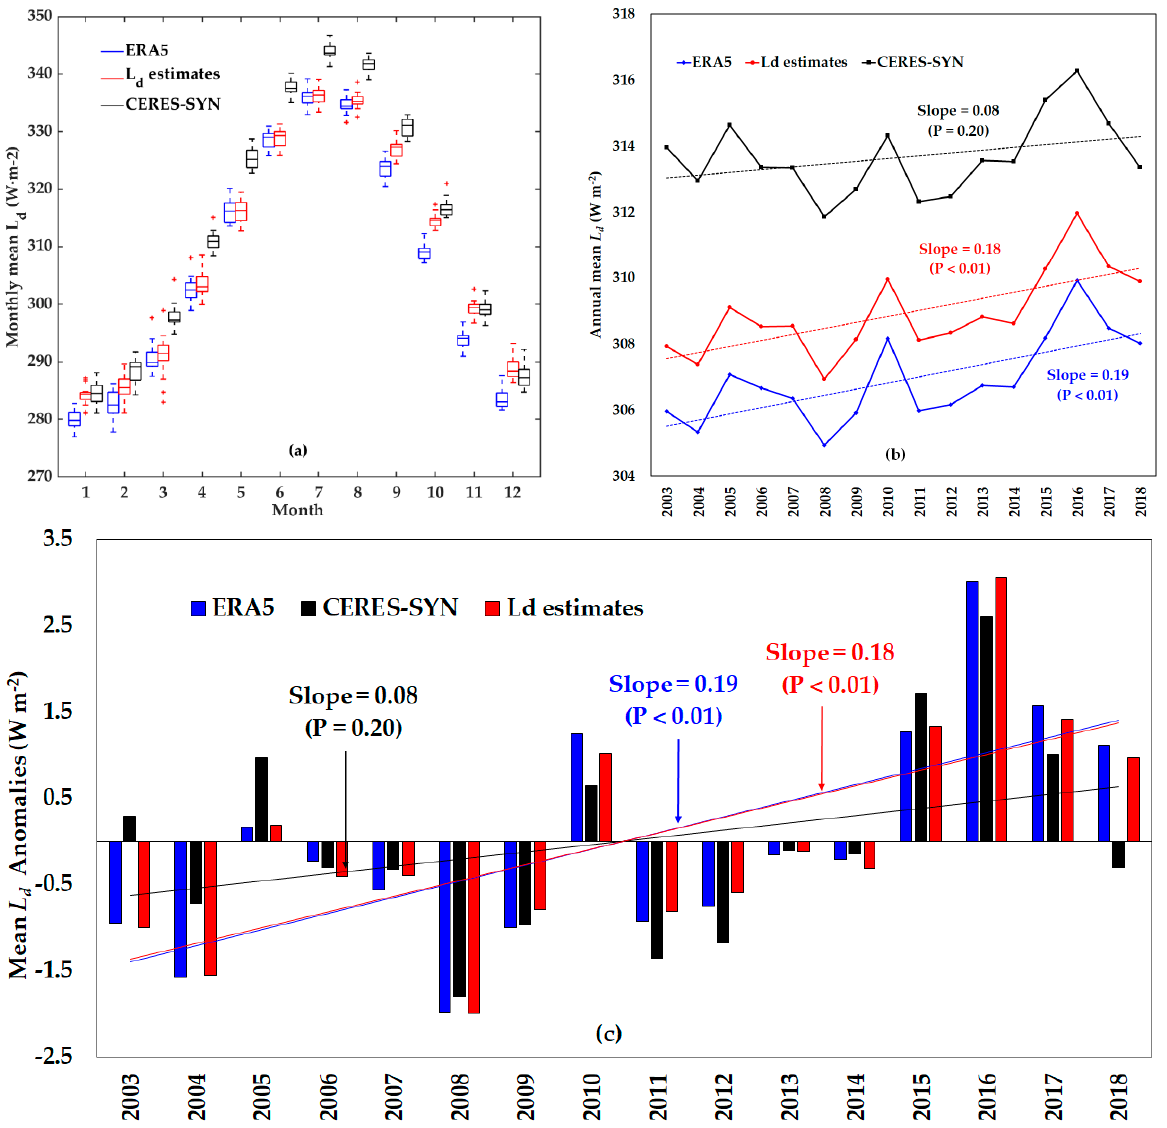
Figure 10. Multiyear ( a ) monthly mean values, ( b ) annual mean values, and ( c ) annual mean anomaly values of the generated, ERA5, and CERES-SYN L d from 2003 to 2018, respectively.